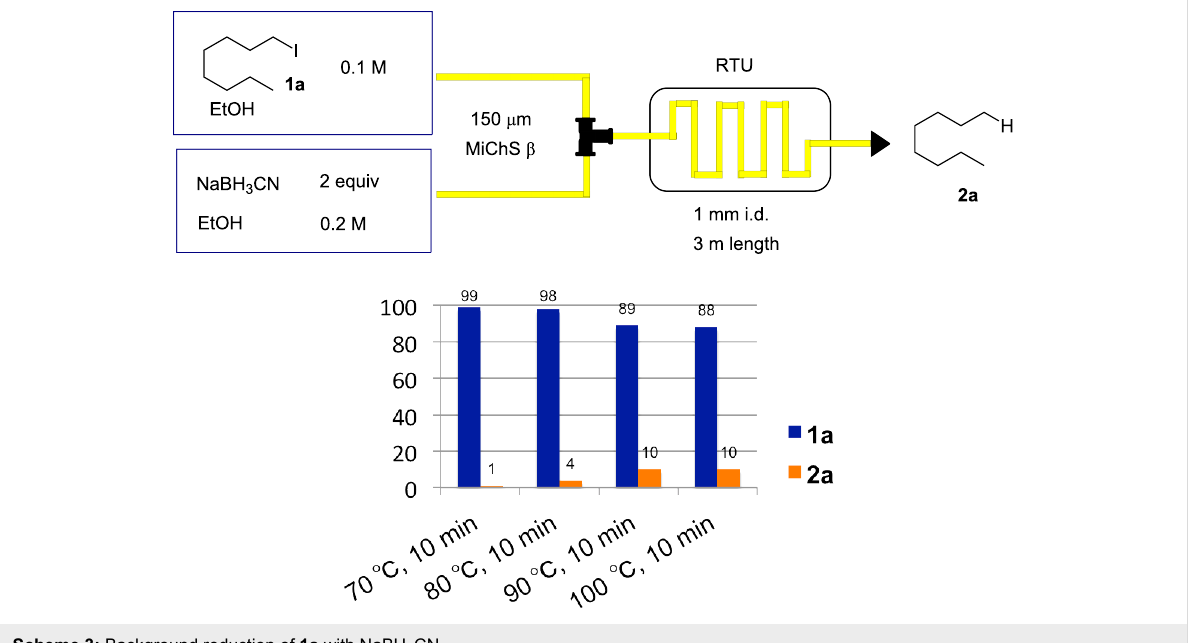
Scheme 3: Background reduction of 1a with NaBH 3